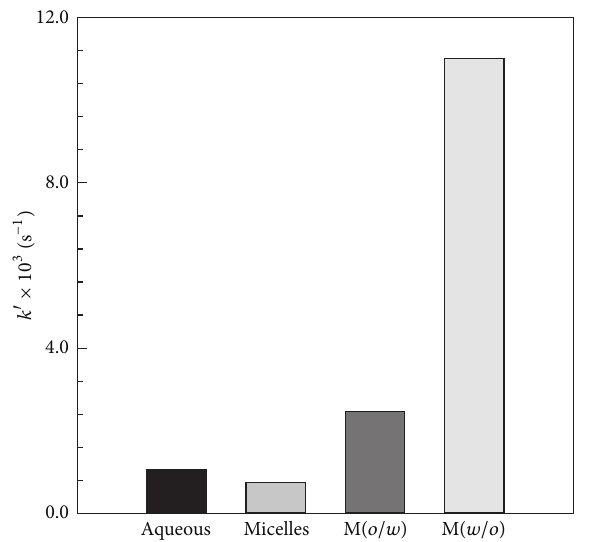
Figure 3: The 𝑘 󸀠 for aqueous and different self-assembled systems based on CTAB; [Bz] = 2.21 × 10 −5 M and [H + ] = 0.001 M. Micelles ([CTAB] = ca. 0.5 M); 𝑜/𝑤 ( 𝑤 𝑜 = 70.9) and 𝑤/𝑜 ( 𝑤 𝑜 = 3.64) micro-